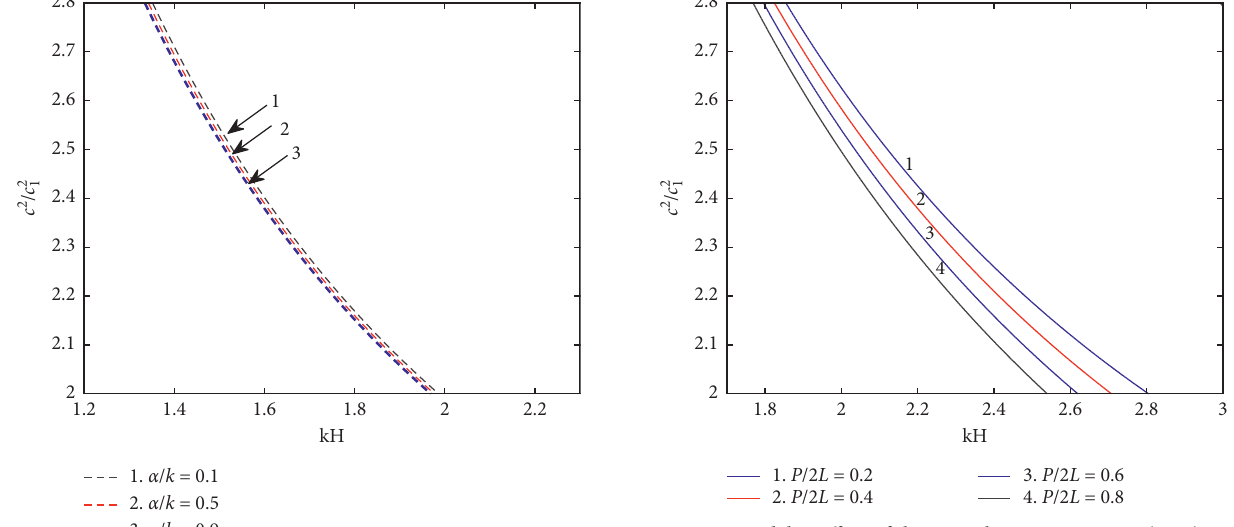
Figure 6: Model-I: effect of the irregularity parameters ( x / H ) and ( bH ) under rigid mountain